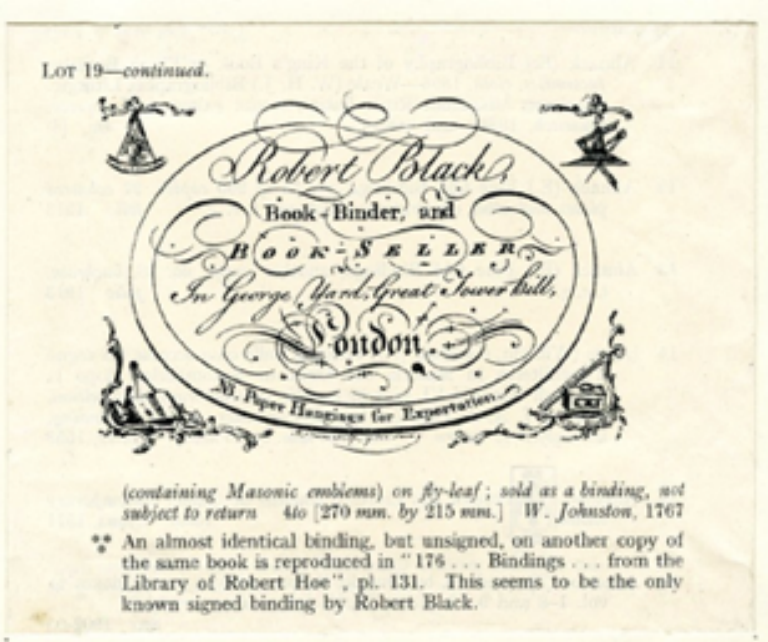
Fig. 36. Trade card of Robert Black, bookbinder. Copyright, The Trustees of the British Museum. Heal, 16.5.